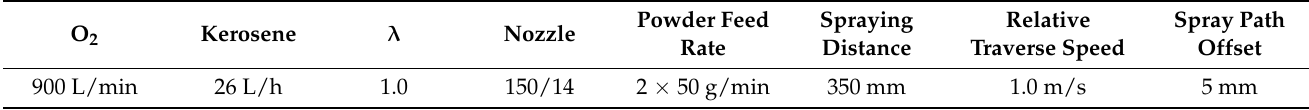
Table 2. HVOF thermal spray parameters for the deposition of HMnS EN 1.3401.